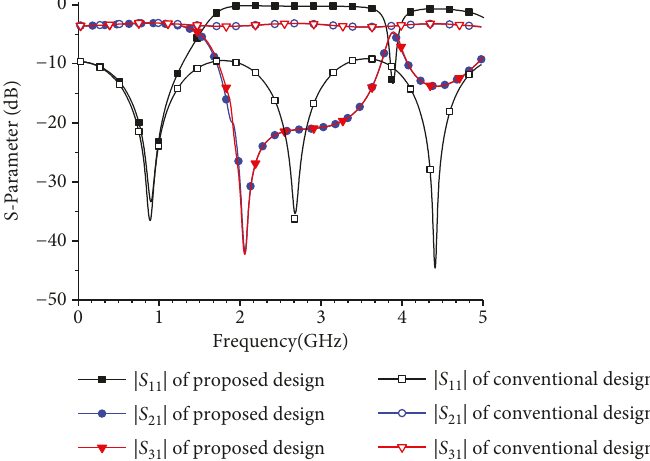
and phase di ff erence of the proposed Wilkinson power divider. 32